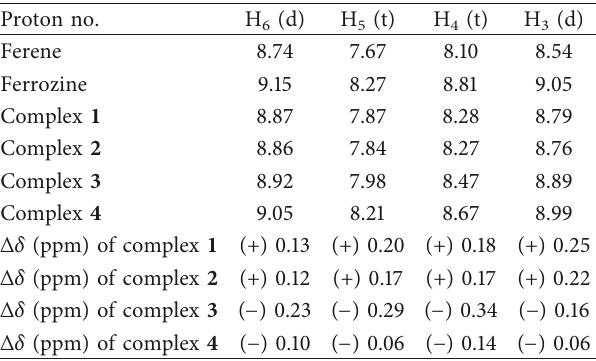
Table 2: Selected 1 H NMR chemical shifts (ppm) of ferene, fer- rozine, and complexes 1–4 . Proton no.